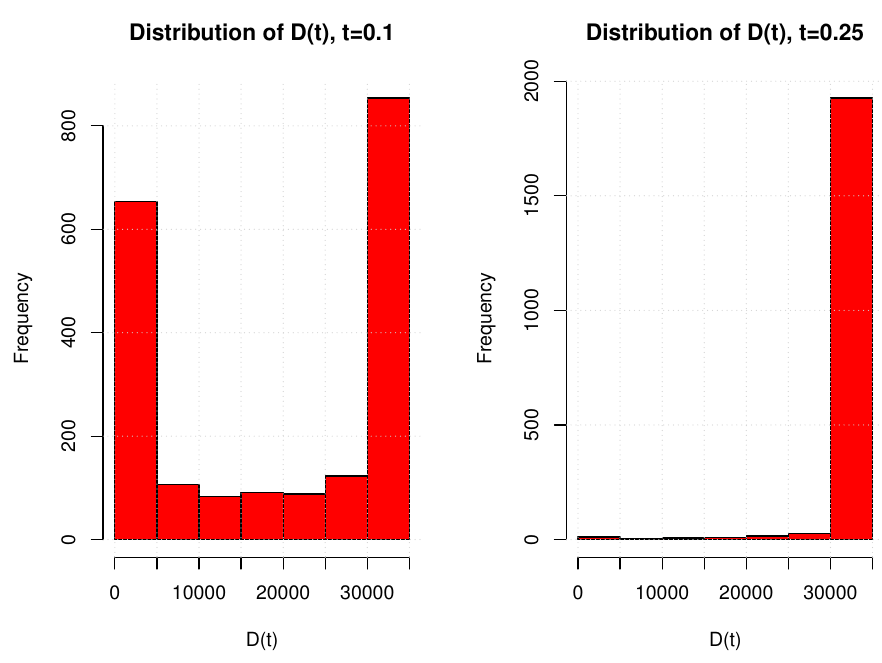
Figure 5. Histograms of the cumulated number of deaths at time t = 0.1 and t = 0.25 for the Italian population. 2000 simulations. Table 8. Expectations, standard deviations, 5% and 95% percentiles of simulated D t . 2000 simulations. E ( D 0.25